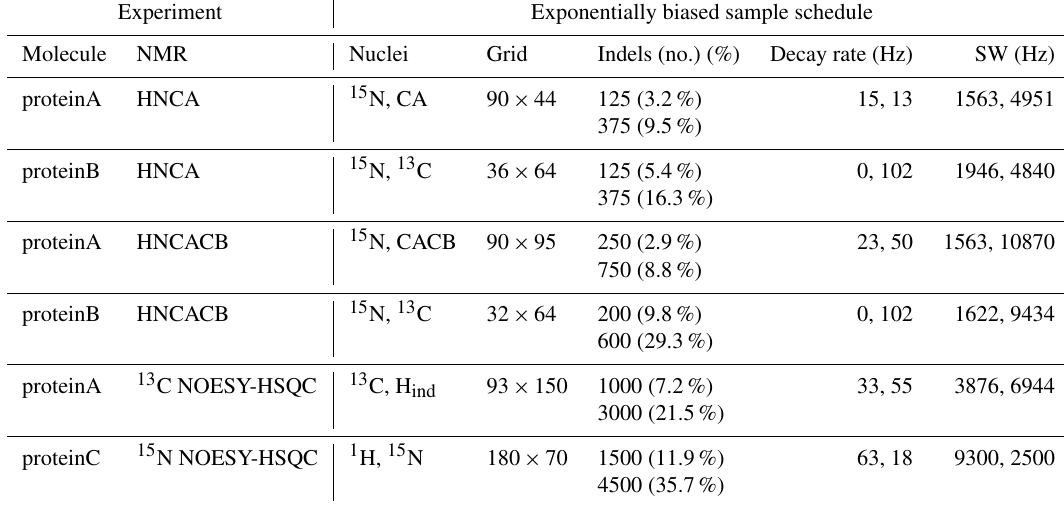
Table 2. Challenge experiments and sample schedules. The left half of the table shows the NMR experiments that define each challenge data set. The right half of the table shows the sampling parameters used to generate a lower and a higher coverage exponentially biased sample schedule for each experiment. The column “Nuclei” lists the indirect dimensions, as specified in the fid.com scripts. The term “Indels” (i.e., “indirect elements”) is a single combination of evolution times taken across all indirect dimensions. Sample schedules customarily list the indels at which FIDs are collected. Dimensions that are constant time are indicated by zero-valued decay